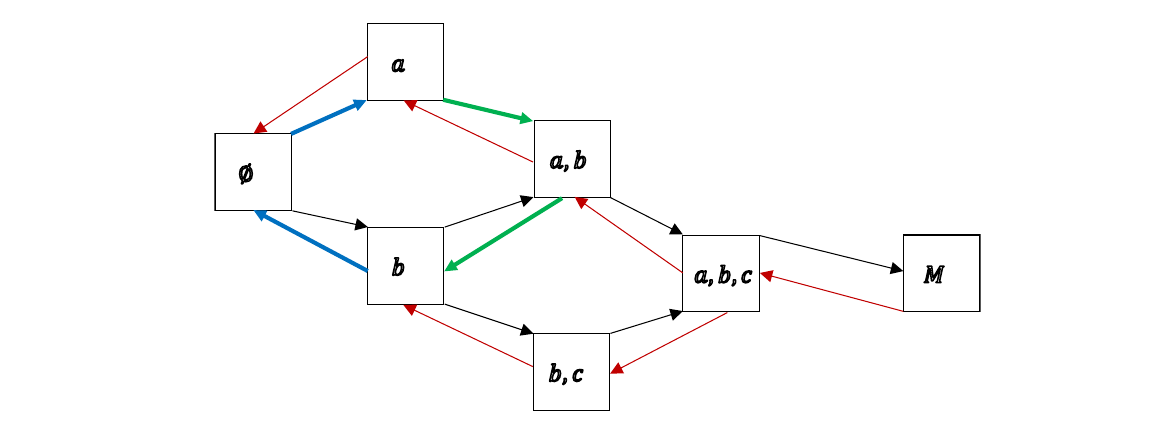
FIGURE1 The directed graphs, in black and red, respectively, of the motivation structure M = {∅ , { a } , { b } , { a , b } , { b , c } , { a , b , c } , M } , with M = { a , b , c , d } . A black arc (directed edge) A −→ B linking the motivation state A (left) to the motivation state B (right) means A ⊂ B ( A subset of B ) and there is no other motivation state between the two. A red arc B −→ A linking the motivation state B (right) to the motivation state A (left) stands for B ⊃ A ( B superset of A ) and there is no other state in between. A trajectory describing the transition from the state of pure external motivation { a } to the state of pure introjected motivation { b } , along directed edges (of both colors) in only states of the motivation structure, is shown in green, { a } −→ { a , b } (black arc) and { a , b } → { b } (red arc). Another trajectory, now from state { b } to state { a } , posited under this model, probably critical empirically, is to become amotivated first, purging the existent introjected motivation, before the other external motivation can be gained, shown in blue. In particular, there is no direct arc linking the two motivation states, thus, according to this model, external motivation cannot be directly converted into introjected motivation and vice versa, but instead, for example, under the green trajectory, must be attained jointly first before the initial one is forfeited to end up with the other. In these graphs, motivations are gained or lost one by one in progressions from state to state. Restrictions of this sort imply serviceable mathematical properties.